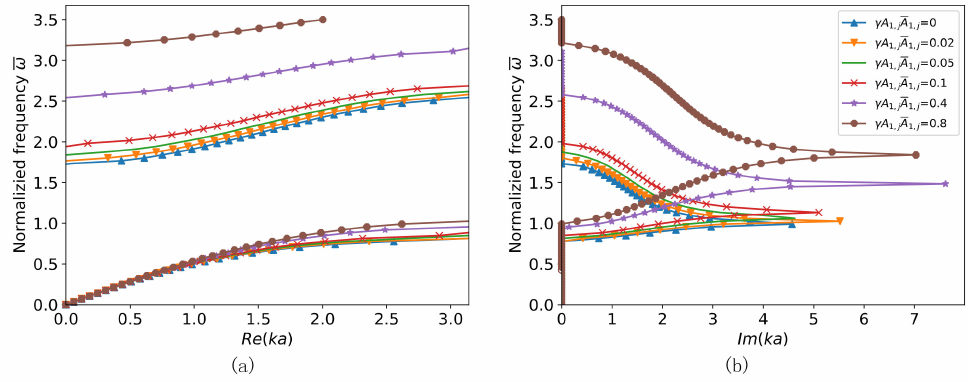
Figure 10. Dispersion relation for the linear EMs with α = 0.5, β = 2 and different γ A 1, n A 1, n